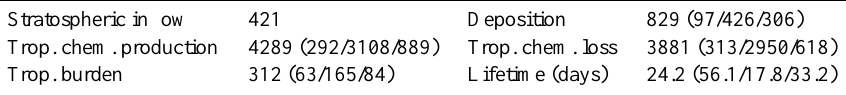
Table 11. The tropospheric chemical budget of O 3 given in Tg O 3 yr − 1 , similar to Table 9. The stratospheric inflow is calculated as the sum of the deposition and the tropospheric chemical loss minus